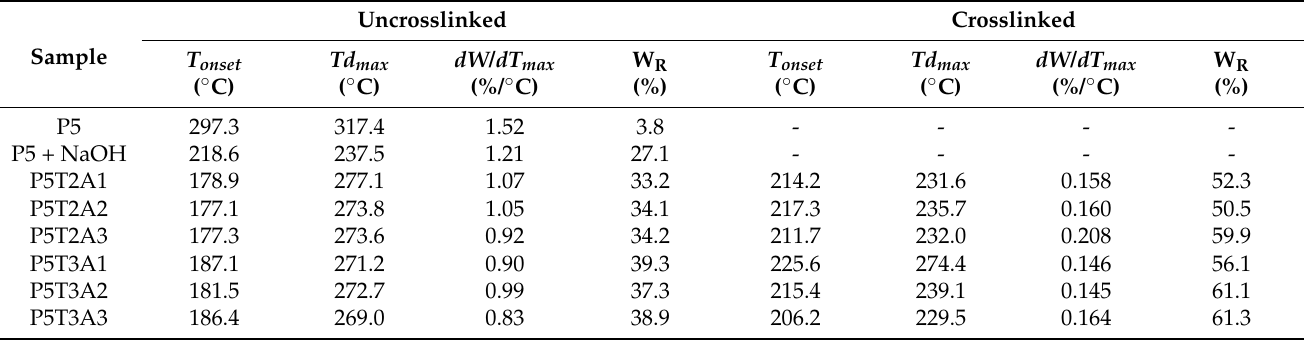
Table 4. Thermal degradation of aerogels.